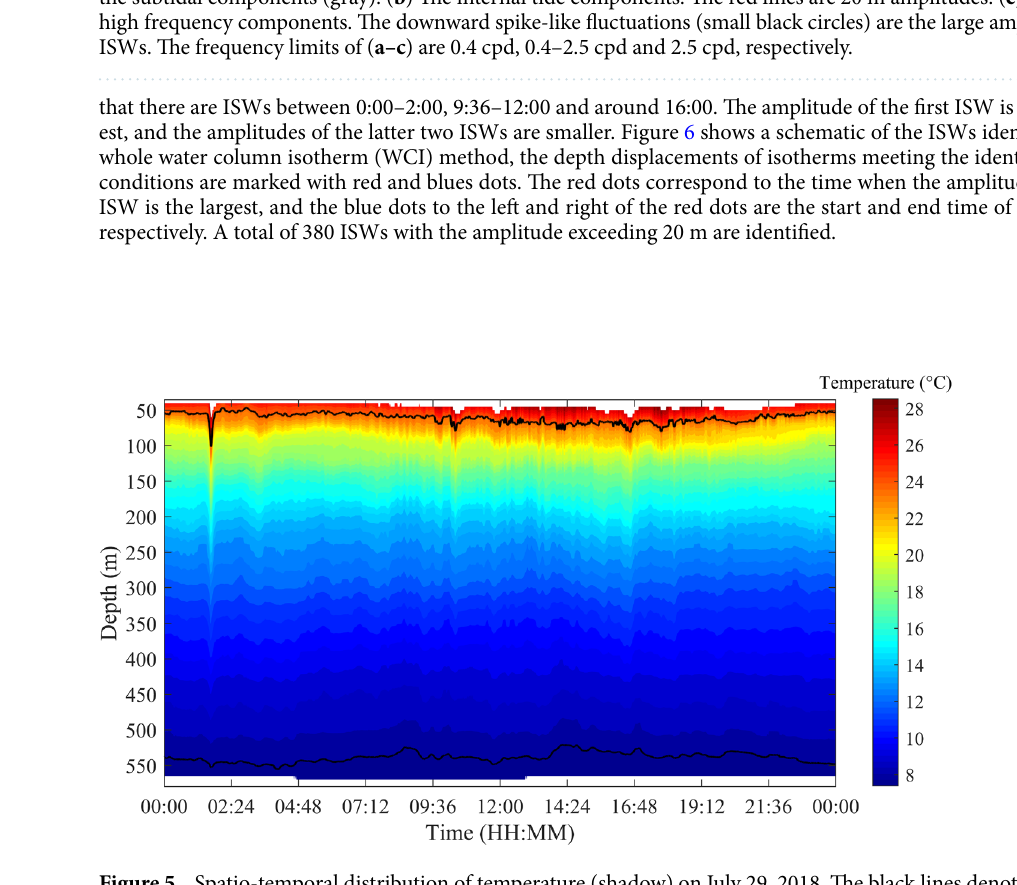
Figure 5. Spatio-temporal distribution of temperature (shadow) on July 29, 2018. The black lines denote 8 and 24 °C isotherms,